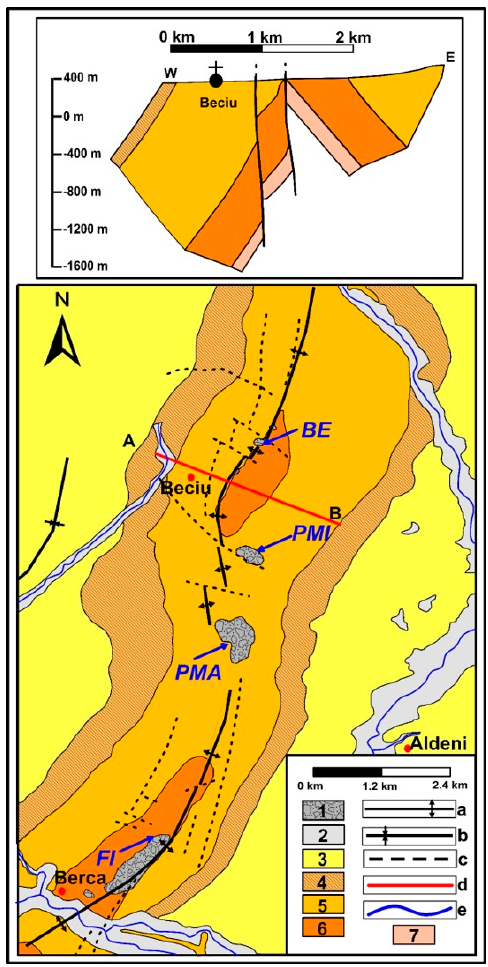
Figure 7. Geological map and cross-section A-B on the Berca-Arbanasi hydrocarbon-bearing structure, showing the position of the mud volcanoes in relation to tectonic structures. 1: mud volcanoes; 2: alluvial sediments; 3: Romanian; 4: Dacian; 5: Pontian; 6: Meotian; 7: middle Miocene; a: anticline; b: syncline; c: fault; d: transect; e: river; BE: Beciu; PMI: Paclele Mici; PMA: Paclele Mari; FI: Fierbatori (modified after [30]).